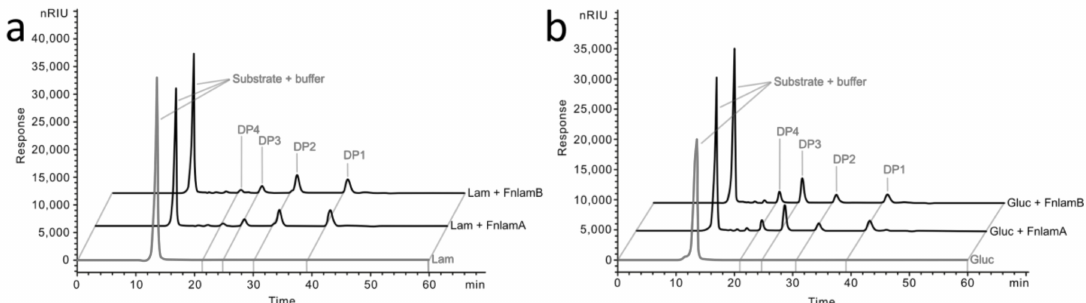
Figure 5. HPLC analysis of products from polysaccharide degradation. Hydrolysis products from laminarin ( a ) and barley β -glucan ( b ) after 18 h of incubation at 70 ◦ C. DP: degree of polymerization. DP1: glucose. Lam: laminarin. Gluc: barley β -glucan.